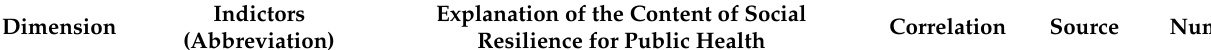
Table 1. Key indicators and correlation of Social Resilience for Public Health